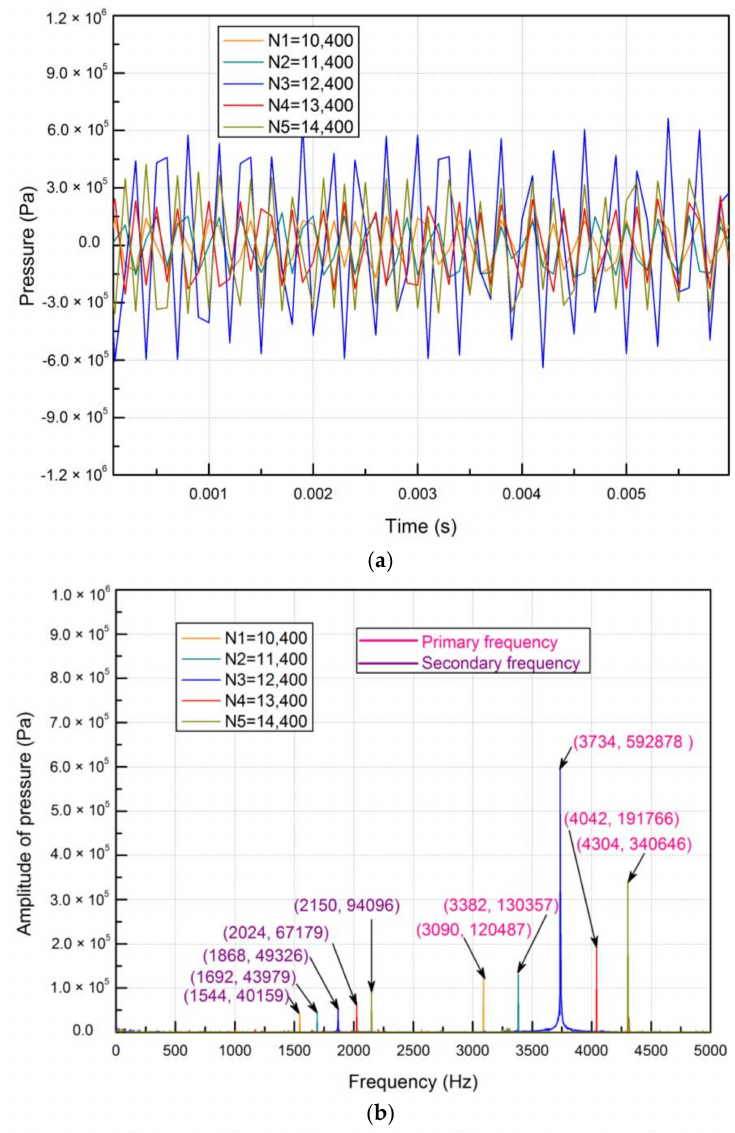
Figure 8. Characteristics of the pressure pulsations at P1 for the Type A flapper-armature assembly: ( a ) in the time domain; ( b ) in the frequency